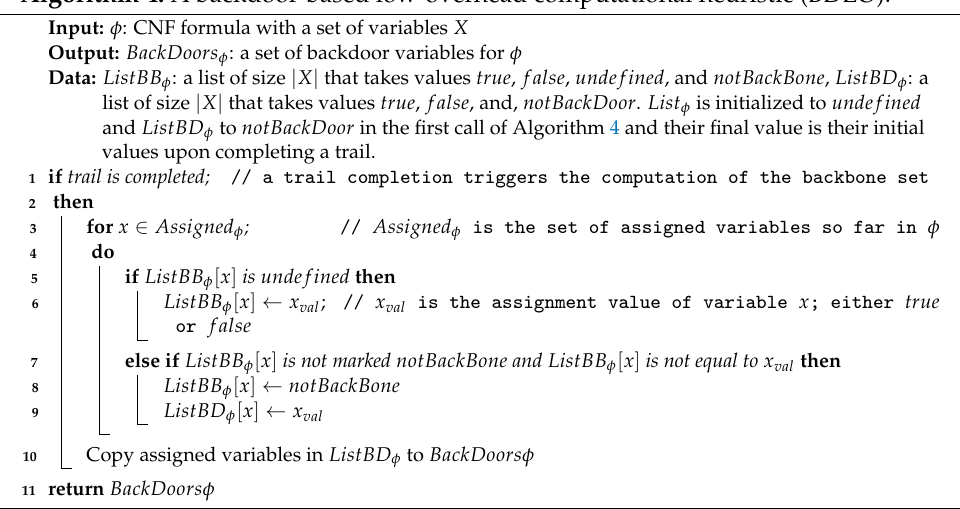
Algorithm 4: A backdoor-based low-overhead computational heuristic